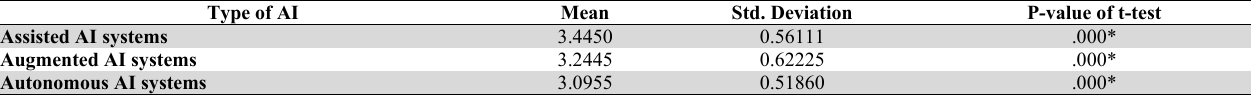
Perceived contribution of AI systems to audit quality